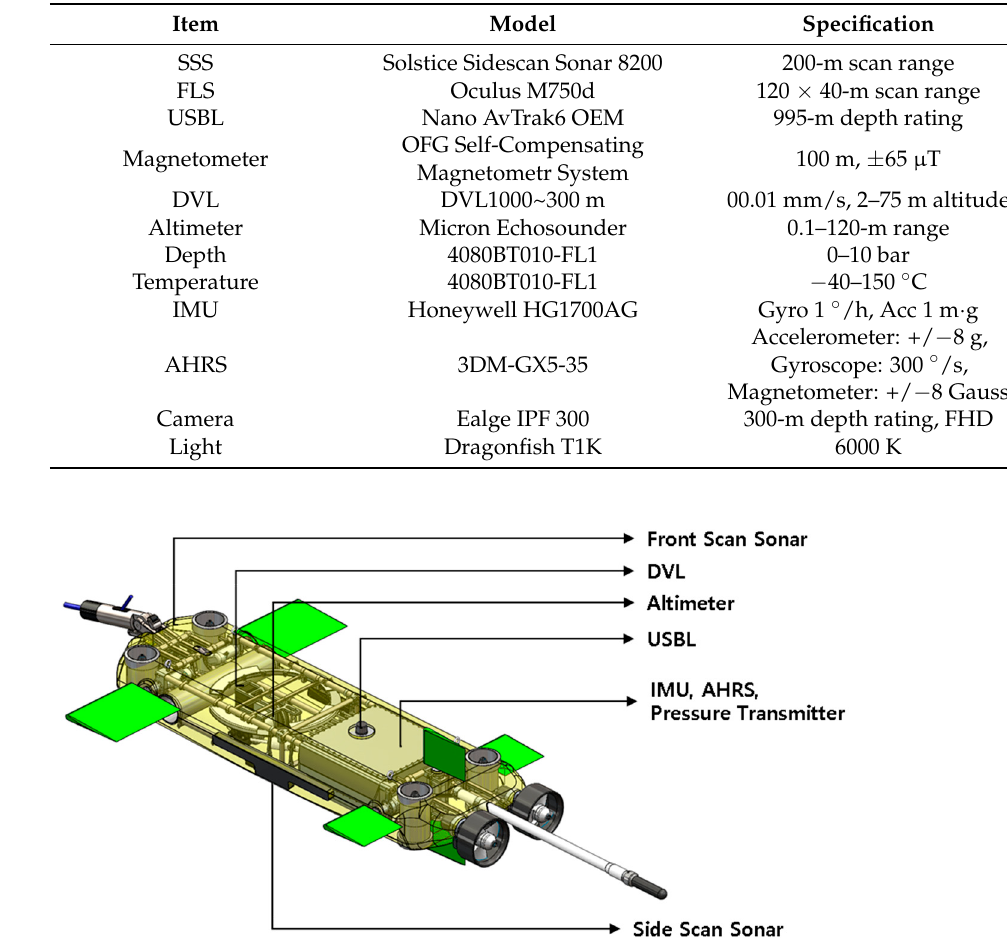
Table 2. TUP sensor specifications.